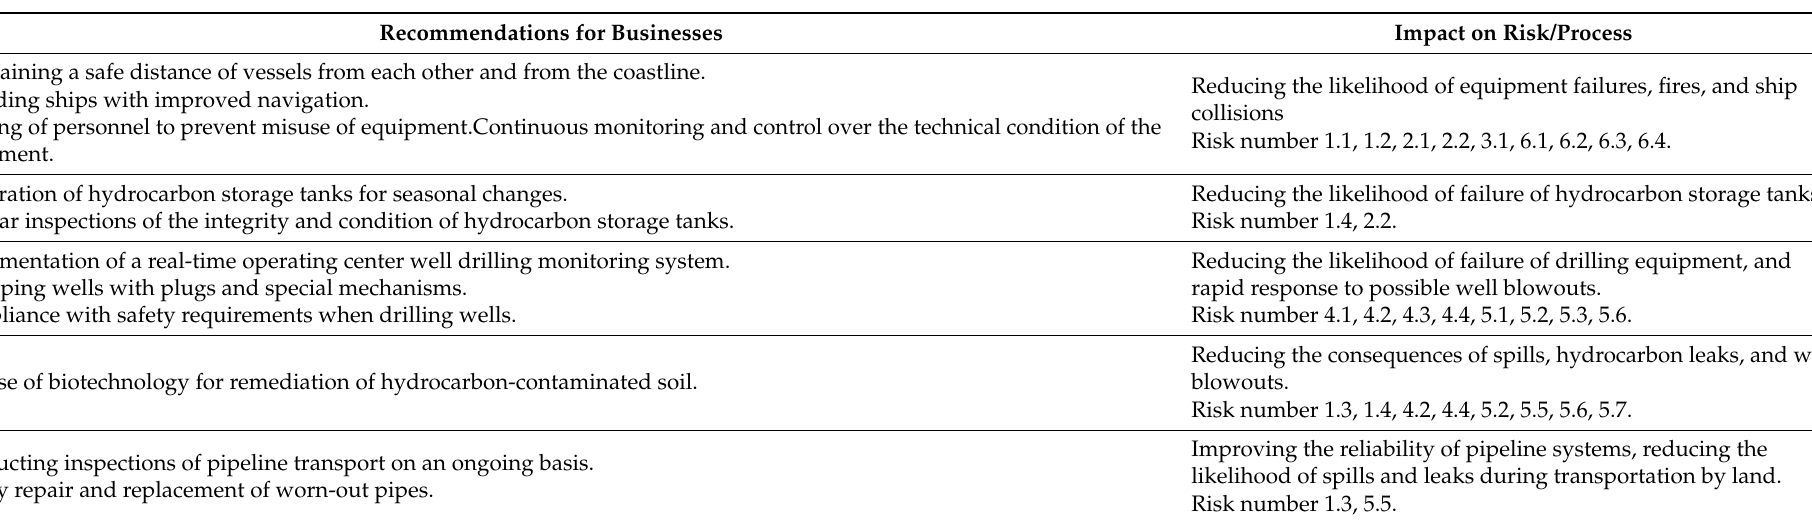
Table 6. Recommendations for businesses on ensuring the sustainable development of the Arctic